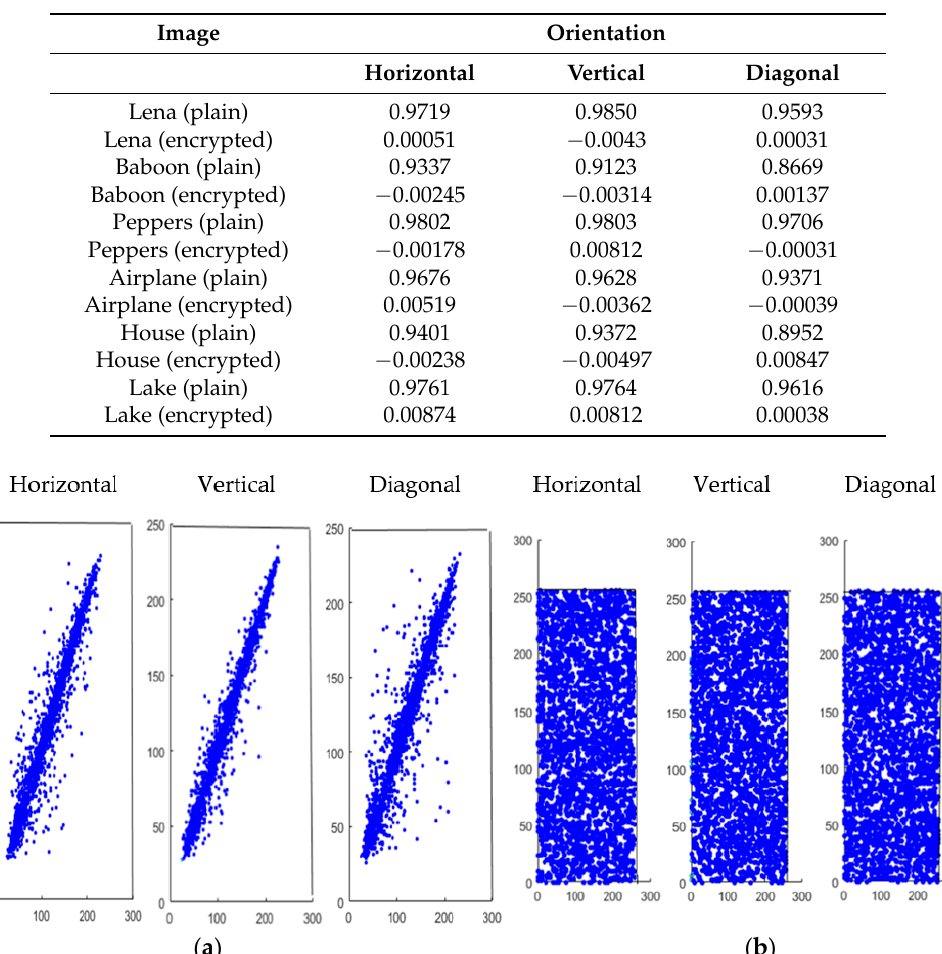
Table 5. Correlation coefficients of adjacent pixels.